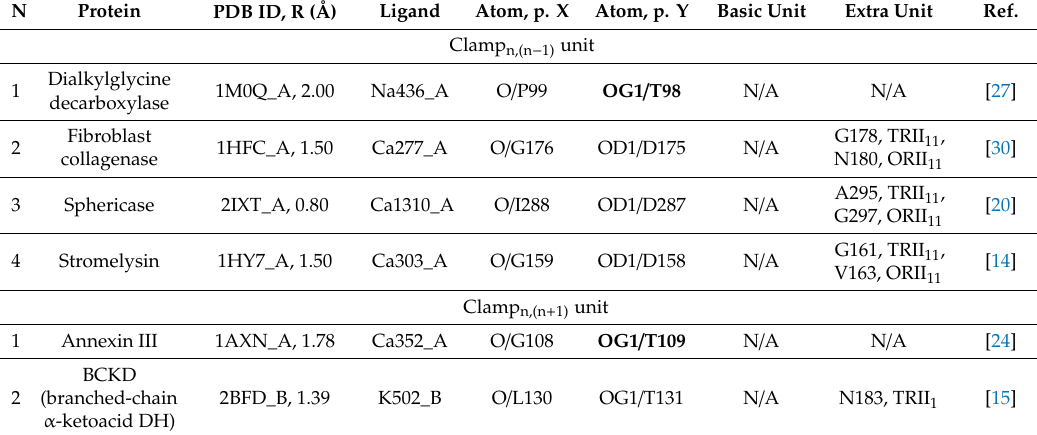
Table 3. Existence of the Clamp n,(n − 1) and Clamp n,(n + 1) units in the metal cation-binding sites of proteins with “niche” motifs in these